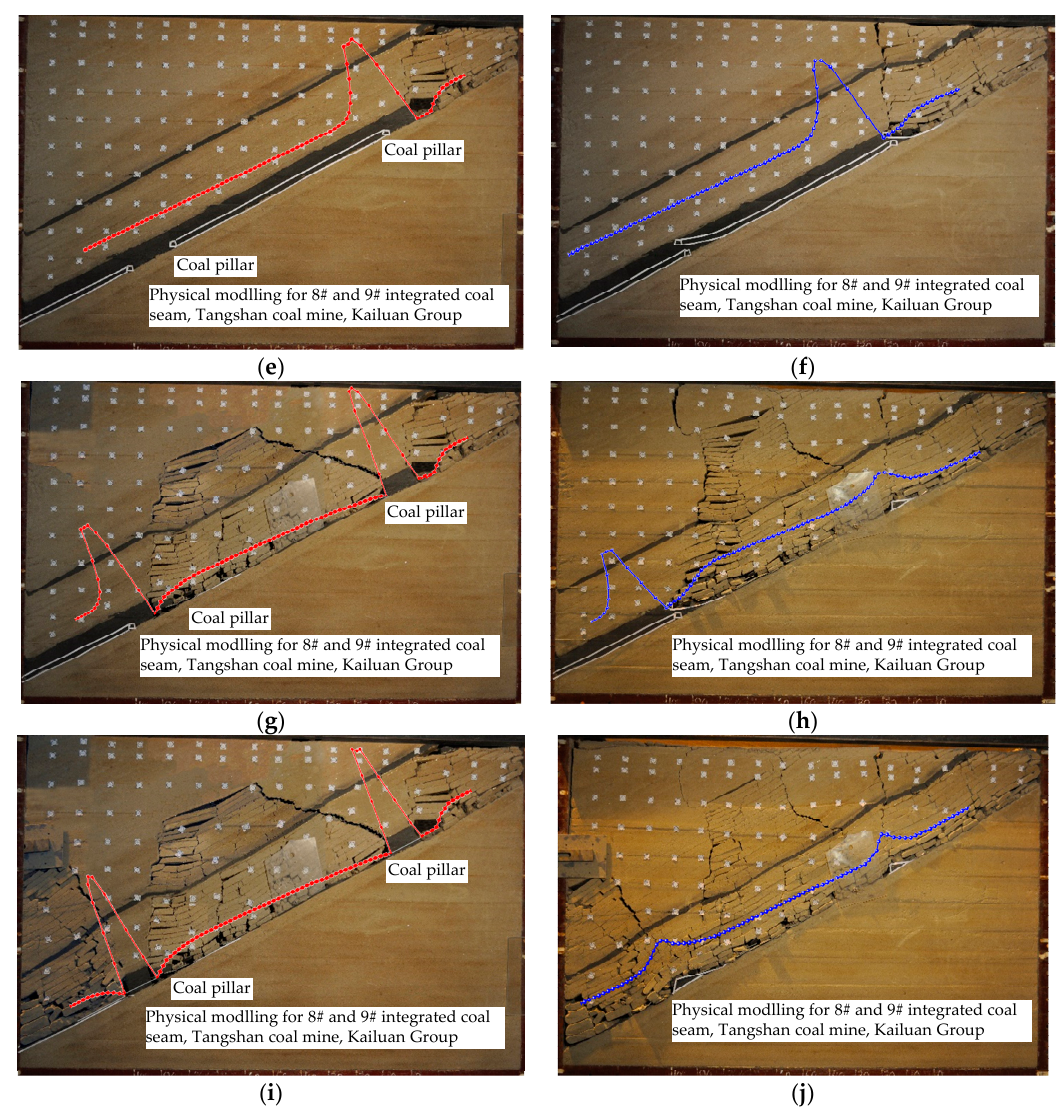
Figure 14. Physical modelling and stress distribution results. ( a ) Physical model; ( b ) sensors and digital data acquisition system; ( c ) CLTCC layout; ( d ) LMSG layout; ( e ) excavation of the previous CLTCC panel; ( f ) excavation of the previous LMSG panel; ( g ) excavation of the Y294 CLTCC panel; ( h ) excavation of the Y294 LMSG panel; ( i ) excavation of the next CLTCC panel; ( j ) excavation of the next LMSG panel.